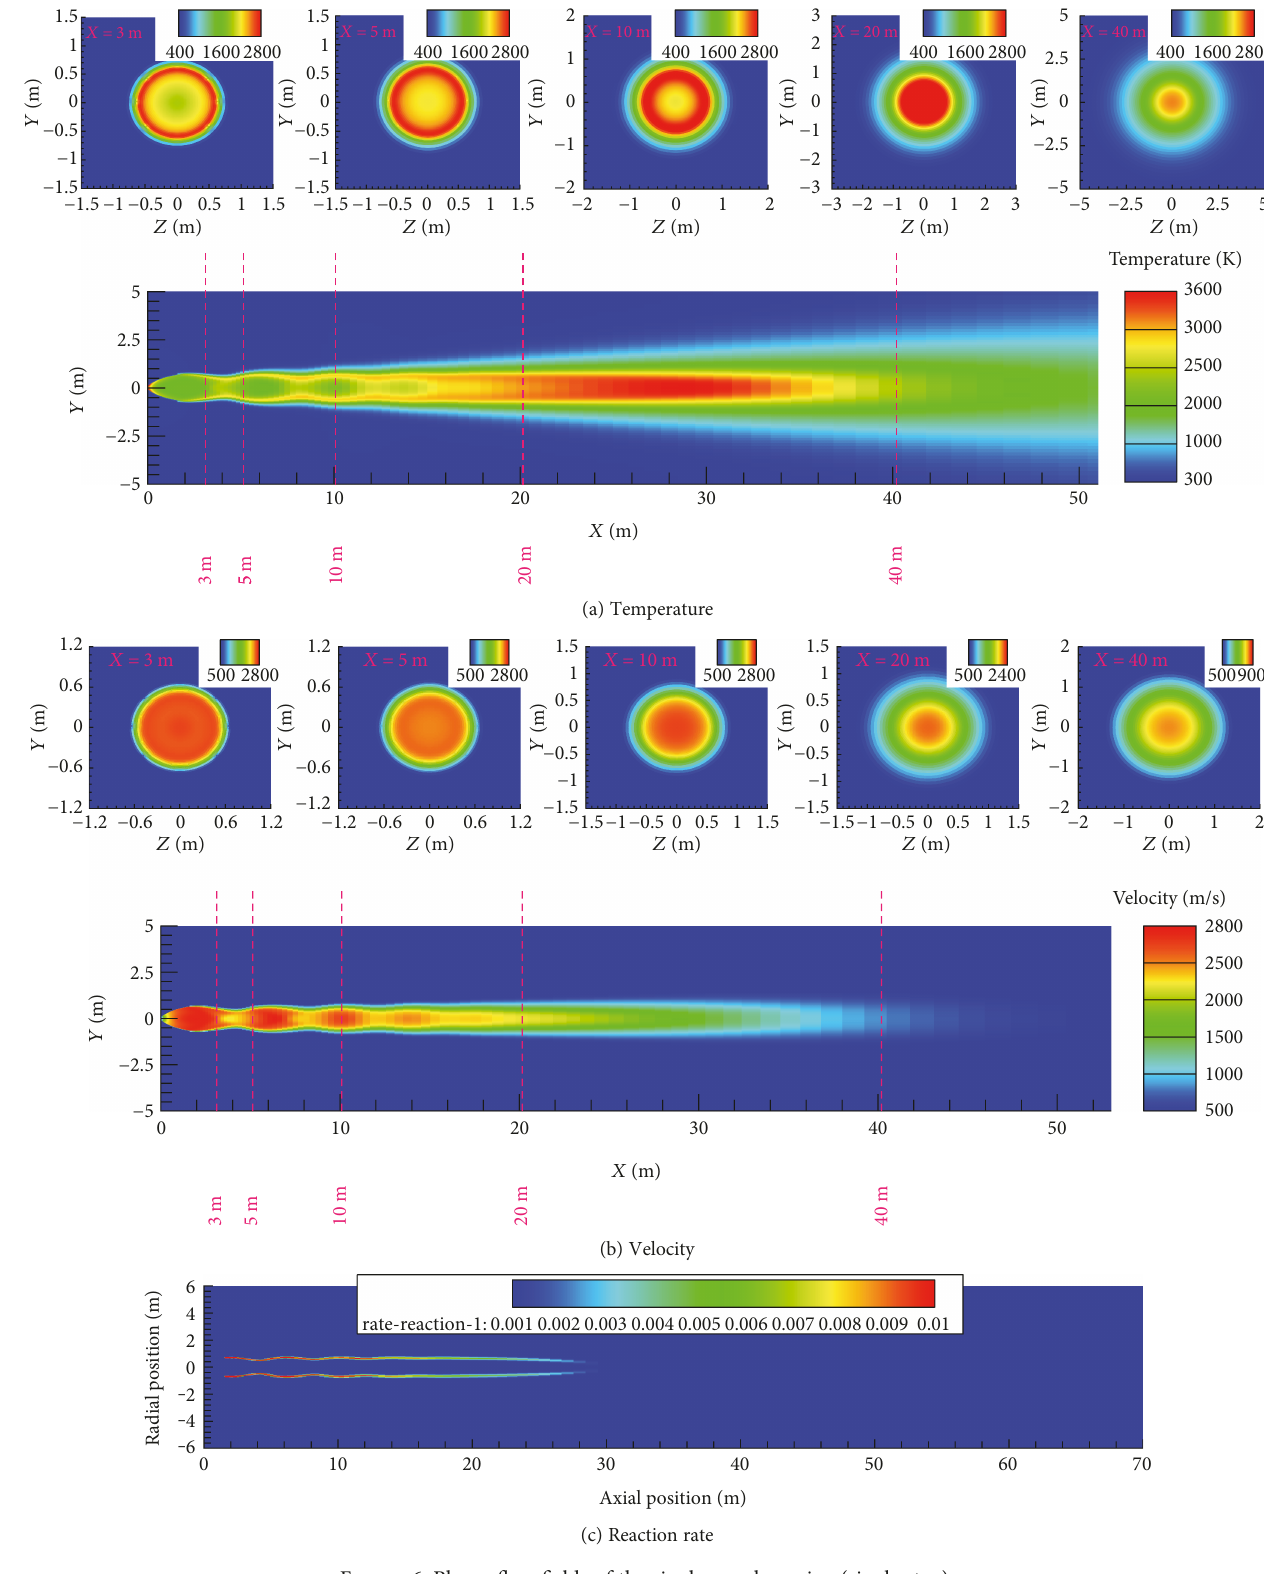
Figure 6: Plume fl ow fi elds of the single-nozzle engine (single